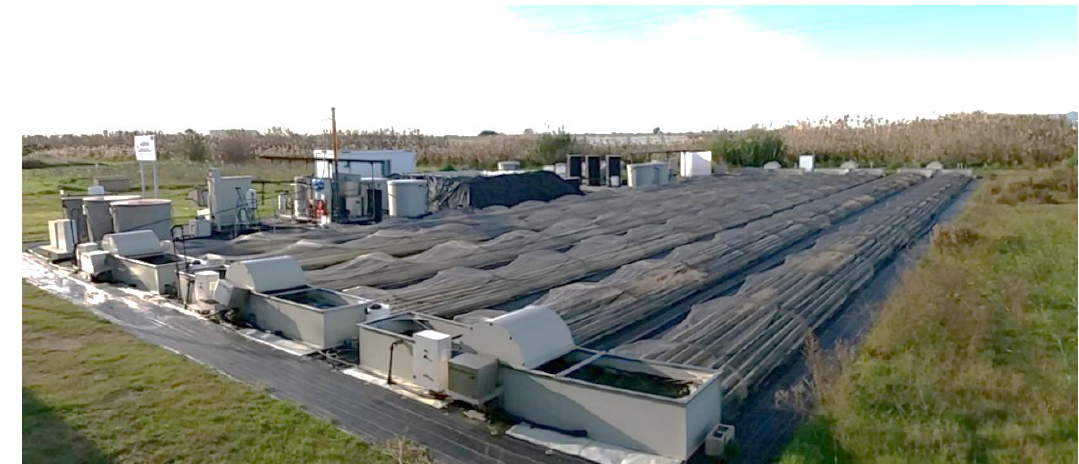
Figure 1. Global view of the demonstration-scale